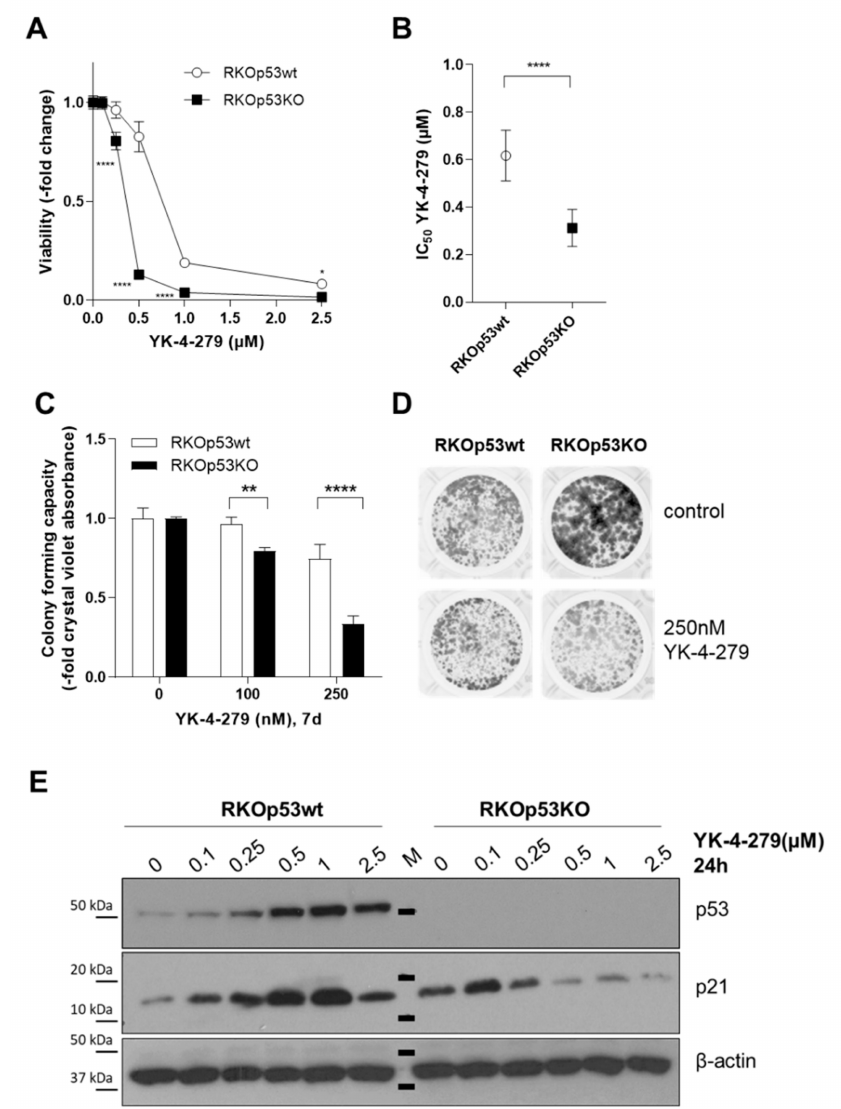
Figure 1. Loss of p53 mediates hypersensitivity to YK-4-279. ( A ) Impact of 72 h exposure to YK-4-279 at the indicated concentrations on viability of RKO colon carcinoma cells with wild-type (RKOp53wt) or deleted p53 (RKOp53KO) background was determined by 3-(4,5-dimethylthiazol-2-yl)-2,5- diphenyltetrazolium (MTT)-based survival assay. Values are given as mean ± standard deviations (SDs) of one representative experiment performed in triplicate. Statistical comparison was performed by two-way ANOVA with Bonferroni post-test. ( B ) Mean IC 50 values for RKOp53wt and RKOp53KO cells derived from at least 4 independent experiments are given in µ M ± SD. One-way ANOVA was used to test for statistical significance. ( C ) Colony formation capacity of RKOp53wt and RKOp53KO cells treated for 7 days with YK-4-279 at the indicated concentrations. Results are based on quantification of crystal violet staining (fluorescence intensity). Values are given normalized to untreated controls as means ± SD of one representative out of three experiments performed in triplicate. Statistical analysis was performed by two-way-ANOVA with Bonferroni post-test. ( D ) Representative photographs for the experiment analyzed in ( C ) are shown. ( E ) Protein expression levels of p53 and p21 following YK-4-279 treatment as indicated in the two RKO sublines were analyzed by Western blot. β -actin served as loading control. M = marker. Concerning all statistical analyses, p values less than 0.05 were considered significant, with * p < 0.05, ** p < 0.01, **** p <